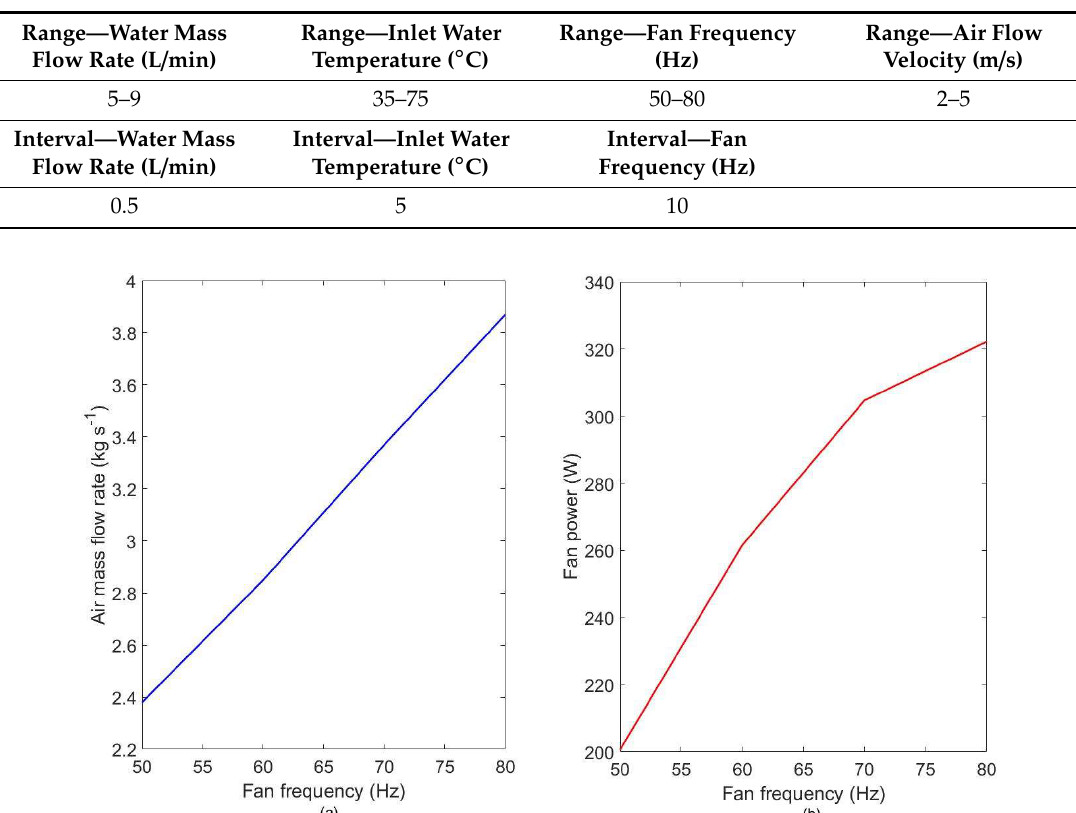
Table 2. Range and interval of the experimental variables.